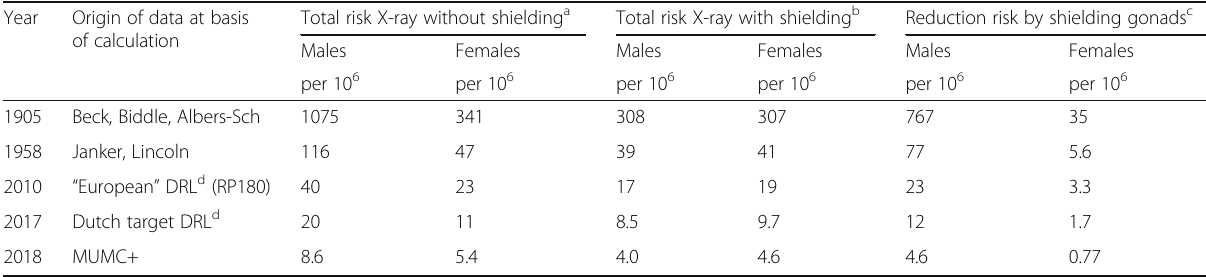
Table 5 Detriment-adjusted risks for adults of reproductive age caused by AP pelvic radiography Year Origin of data at basis of